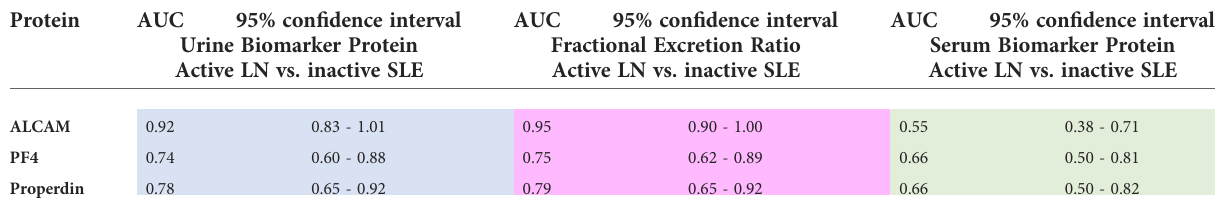
TABLE 4 Validation of FE ratios in an extended cohort of 50 LN patients.